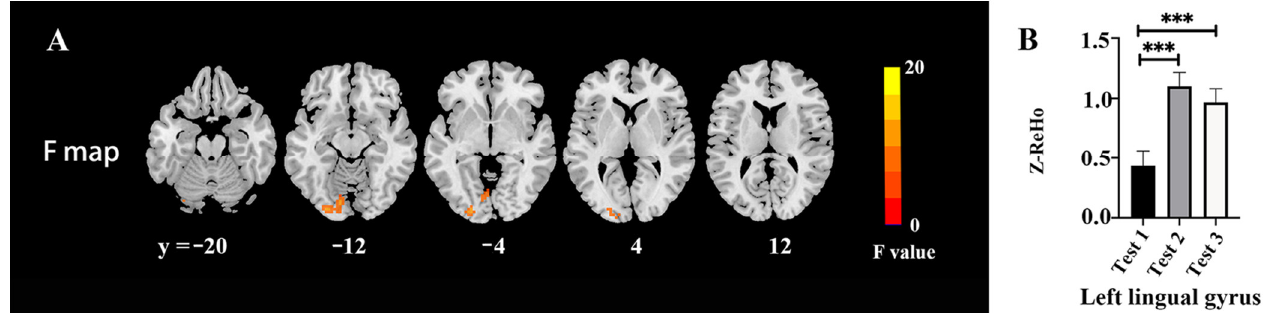
Figure 1. ALFF changes among the three time points: ( A ) Difference of ALFF maps among the three time points; ( B ) extracted clusters of significant ALFF alteration in three time points. * p < 0.05 and *** p < 0.001.